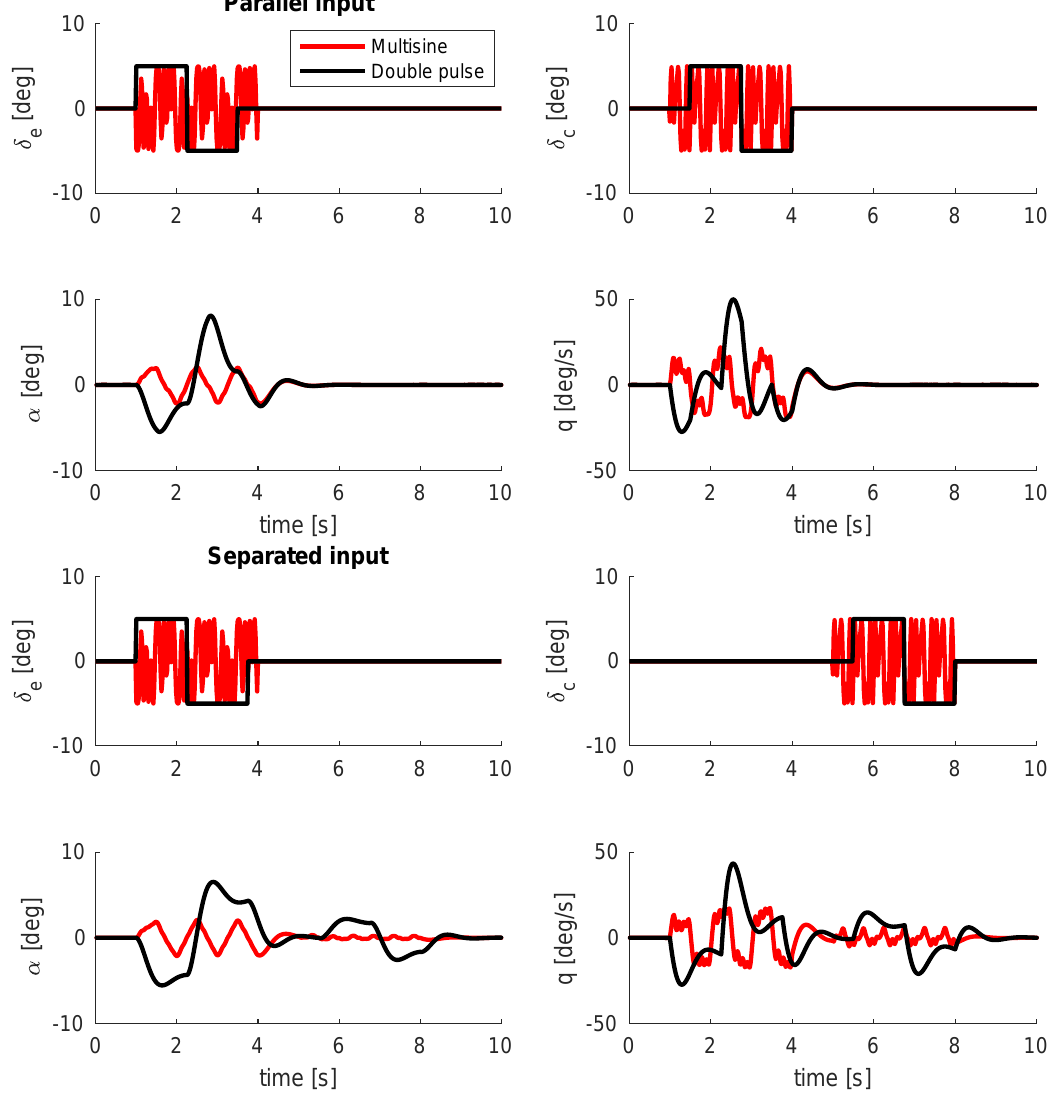
Figure 9. Simulations with different input signals. Crest factor optimized multisine (red) vs. double pulse